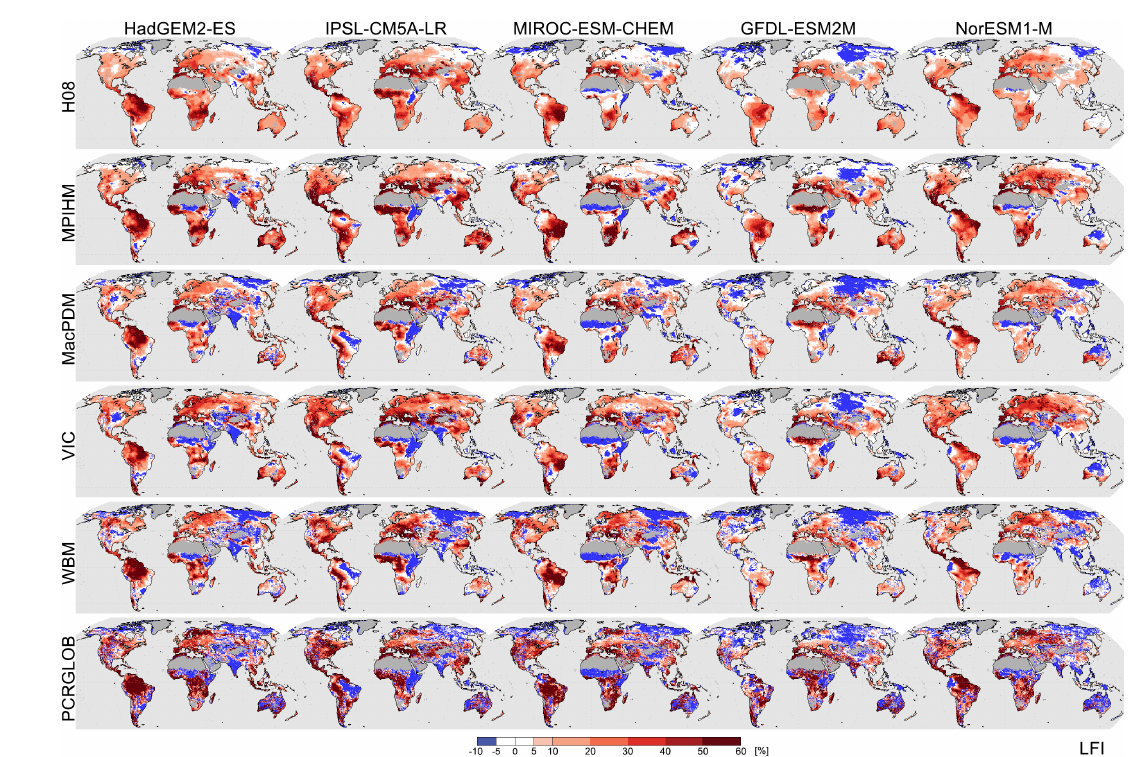
Figure B3. As Fig. 1a, for individual GHM (row) and GCM (column) combination, for LFI.